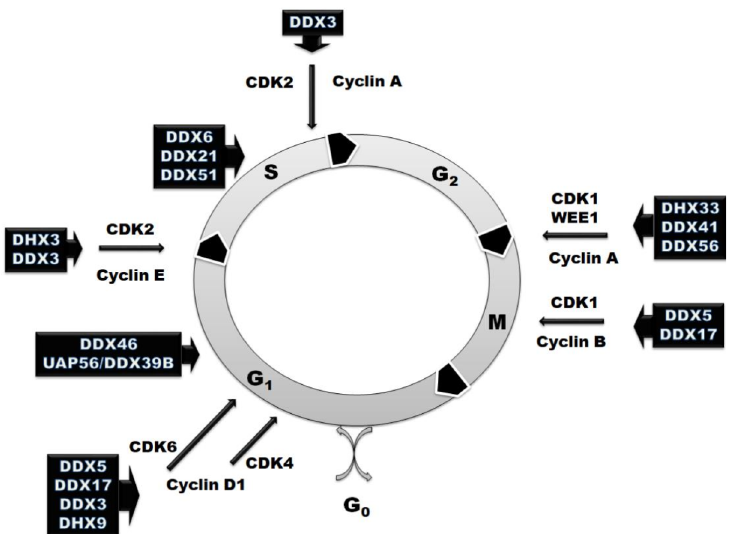
Figure 2. Schematic representation of the involvement of RNA helicases in the cell cycle regulation with marked cyclin-dependent kinases (CDKs) and their regulatory partner proteins, the cyclins based on the analyzed published data represented in Table